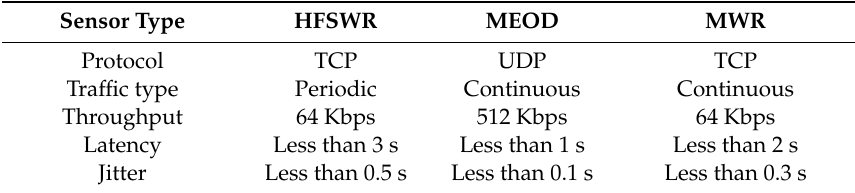
Table 1. Real sensor network